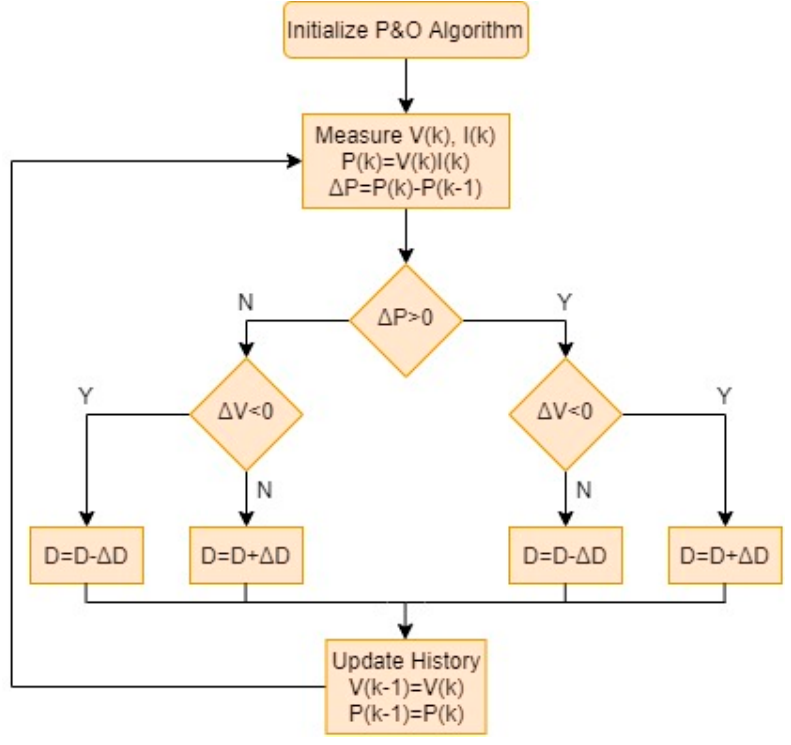
Figure 3. Perturb and observe (P&O) algorithm flowchart.